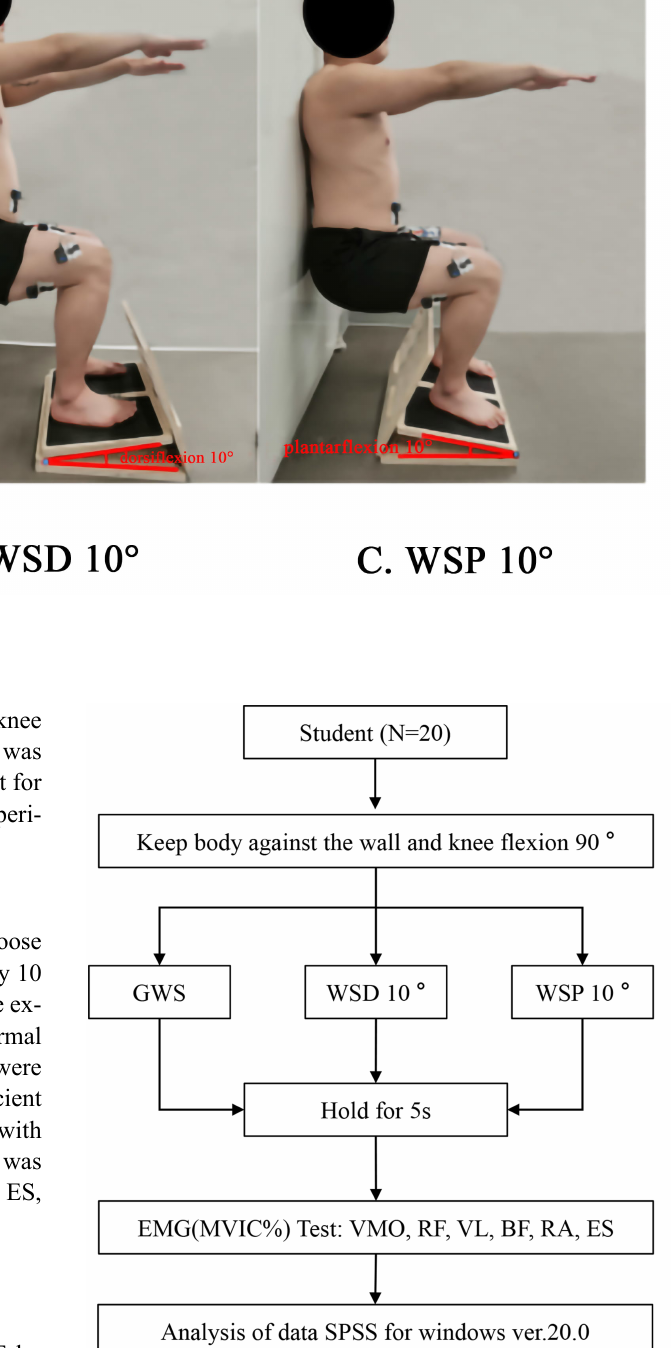
Fig. 2. Study flow chart. VMO, vastus medialis obliques; VL, vastus lateralis; RF, rectus femoris; BF, biceps femoris; RA, rectus abdominis; ES, erector spinae; GWS, general wall squat; WSD 10°, wall squat with dorsiflexion 10°; WSP 10°, wall squat with plantarflexion